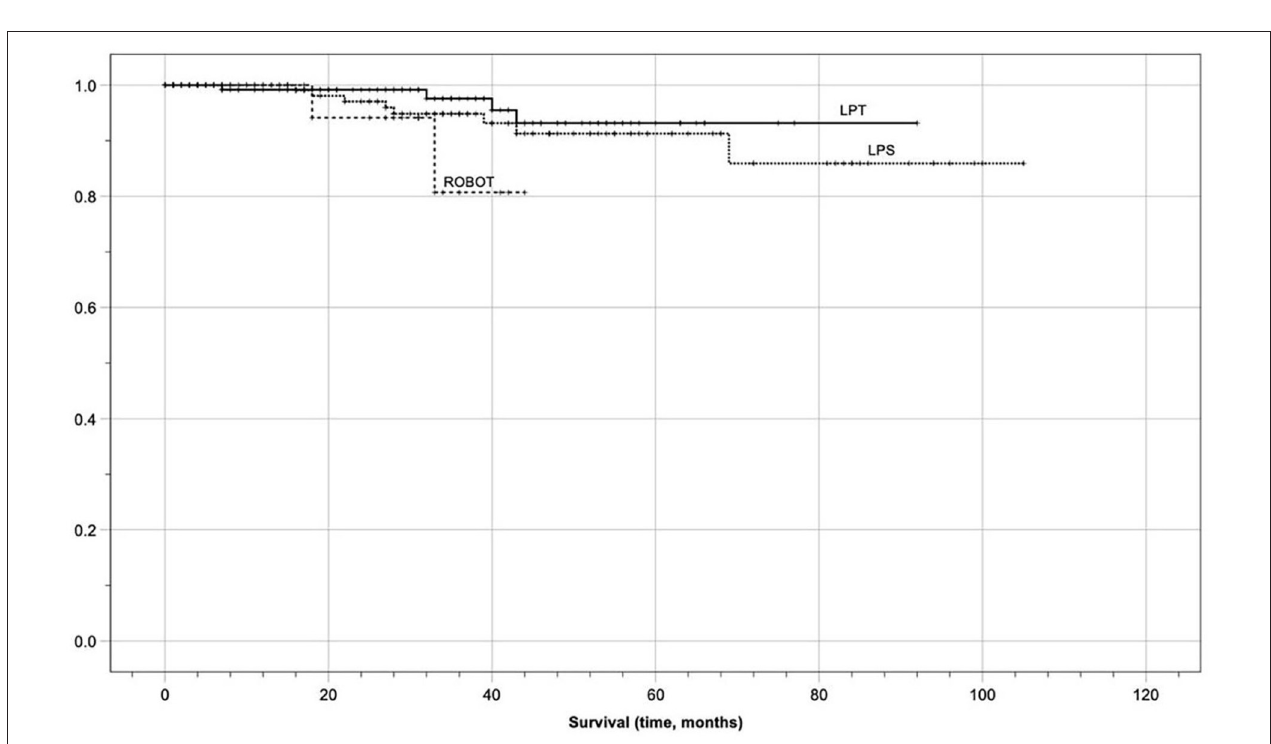
FIGURE 2 | Kaplan meier survival analysis (disease-free